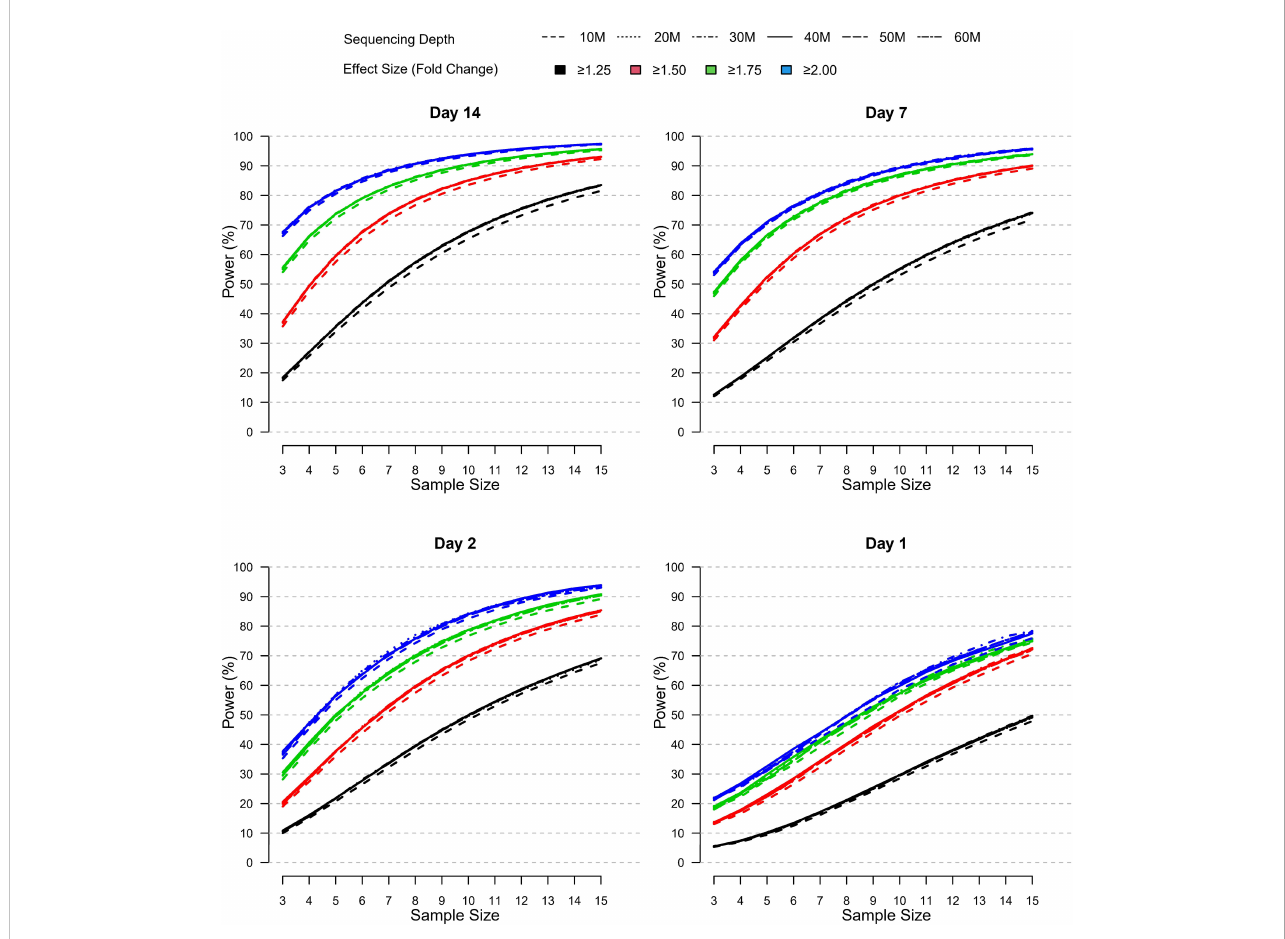
FIGURE 7 Relative power by sample size, effect size, and sequencing depth at each post-vaccination day as simulated using the modi fi ed PROPER R package. Days were sorted by decreasing vaccination effect based on overall fold changes and DEG responses observed for this study (see Figure 3A). Power was assessed for different fold-change cutoffs (indicated by color-coded lines), sequencing depth (as indicated by the line type), and sample size